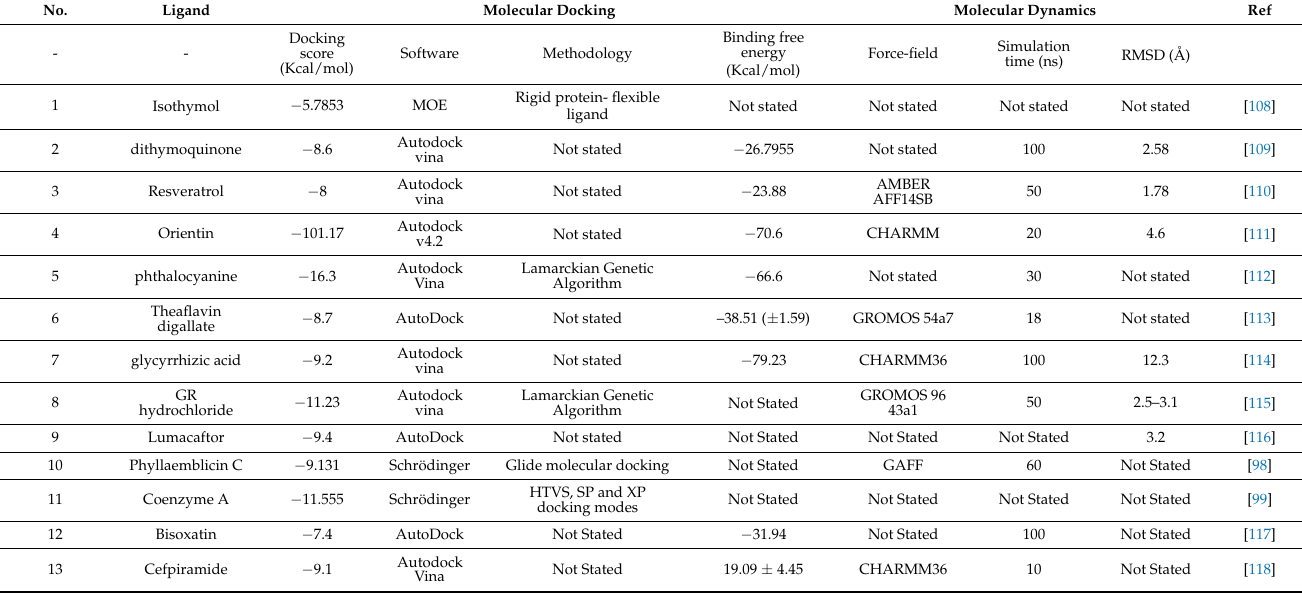
Table 2. Computational studies of spike protein or spike protein–ACE2 enzyme interface targeting of FDA re-purposed drugs and natural